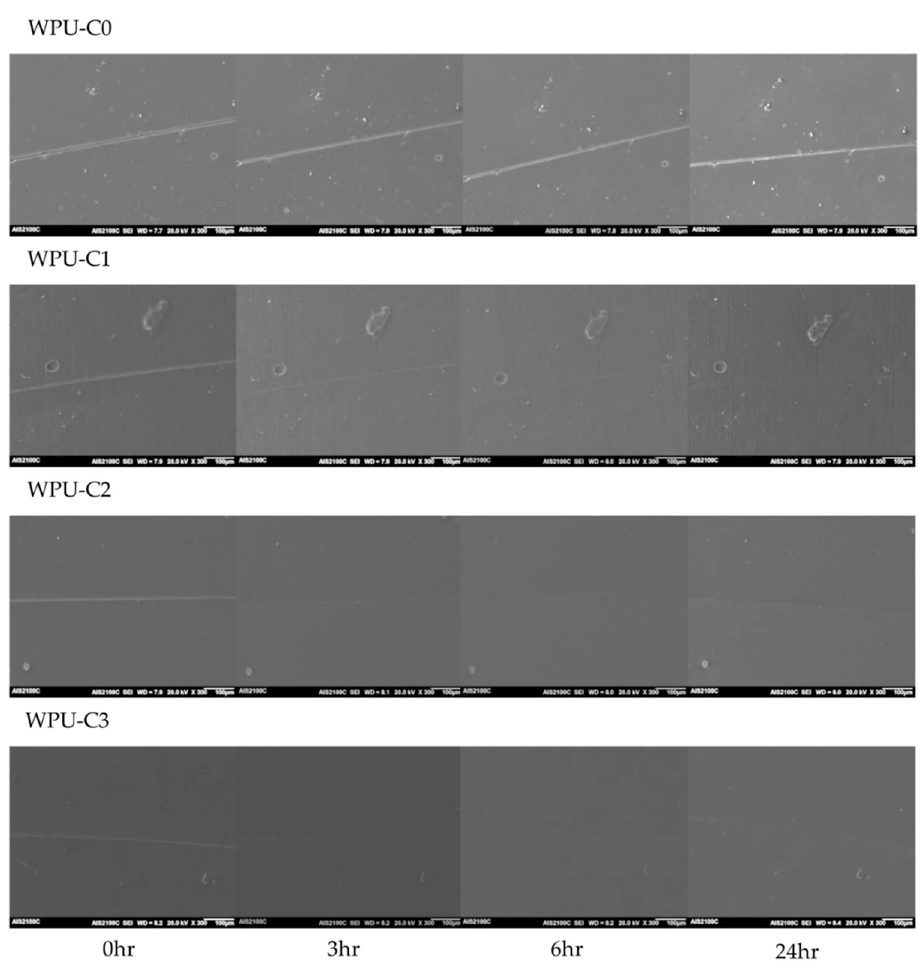
Figure 7. SEM images of the WPU films during the scratch healing process at 110 ° С .